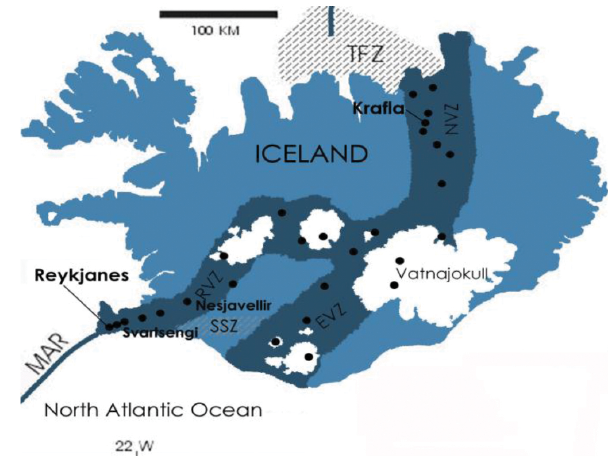
Figure 1. The slow spreading (2cma − 1 ) Mid-Atlantic Ridge (MAR) connects with central neovolcanic rift systems of Iceland (dark blue). Black circles are high-temperature geothermal systems. RVZ = Reykjanes Volcanic Zone; EVZ = Eastern Volcanic Zone; NVZ = Northern Volcanic Zone. The SSZ = Southern Seismic Zone and TFZ = Tjorness Fracture Zone. The white areas are glaciers.